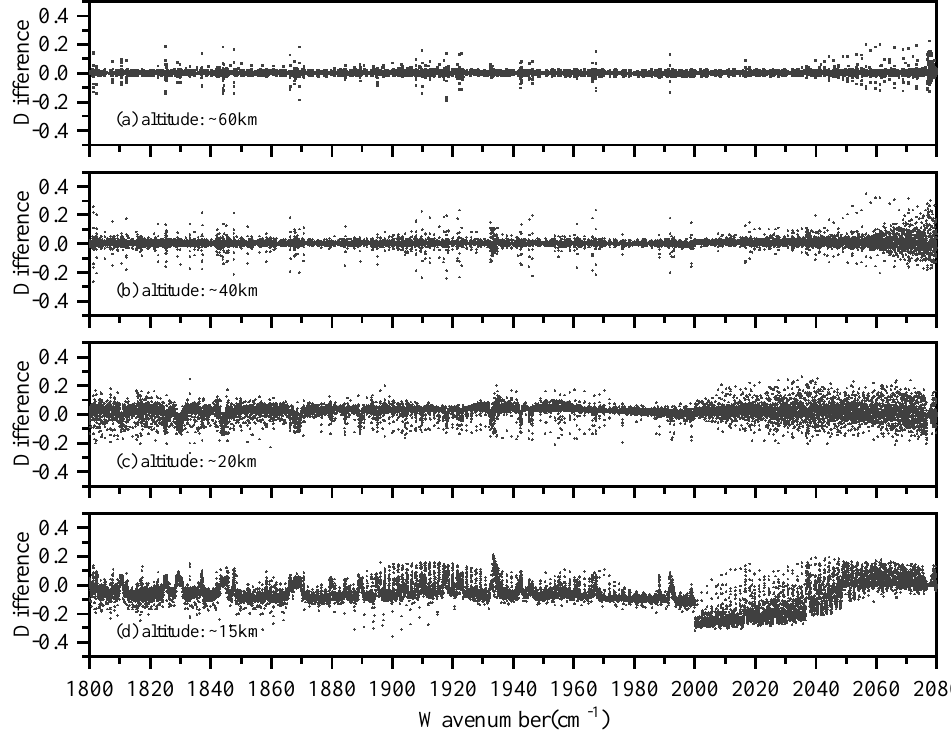
Figure A10. The transmittance differences between AIUS measurements and simulations in 1800–2080 cm − 1